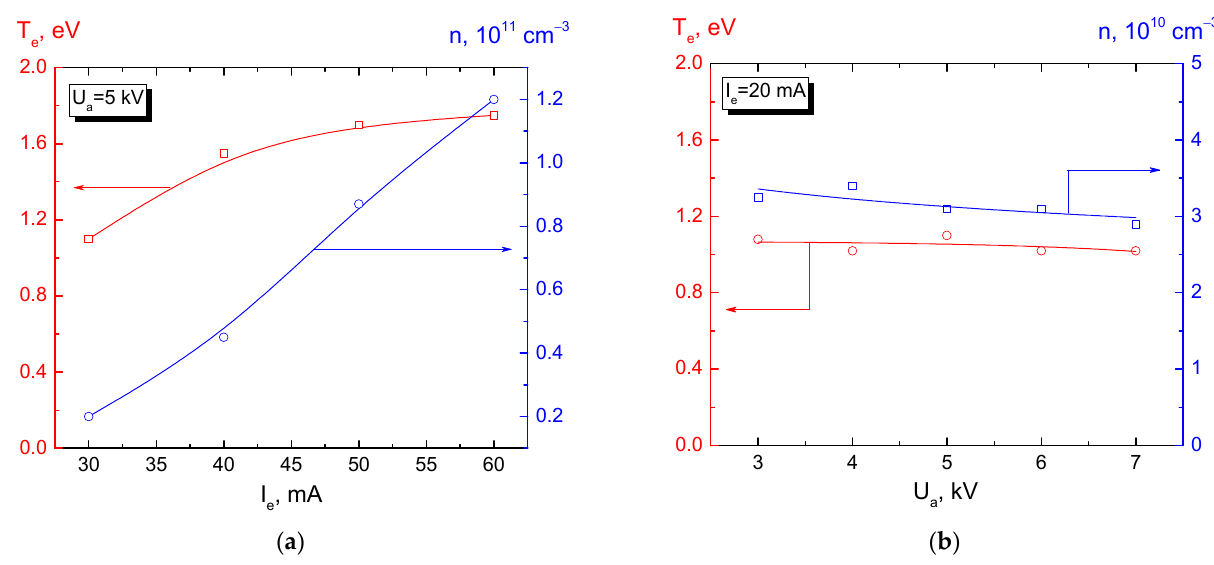
Figure 14. Dependence of parameters ( n , T e ) of the plasma generated in helium (5 Pa) during free